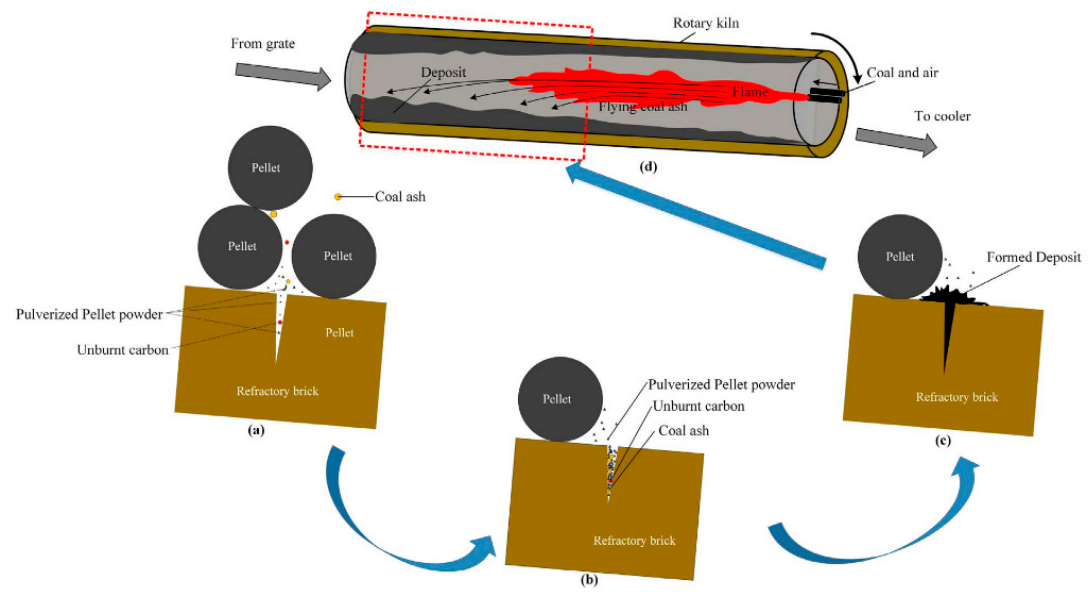
Figure 7. Schematic diagram of the deposit formation process [43] .